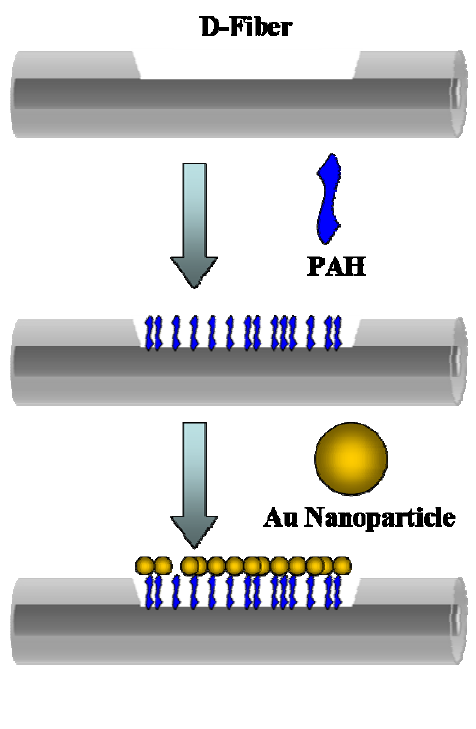
Figure 4. Schematic diagram of the modification of Au nanoparticles on the surface of the grooved optical fiber (D-type fiber was taken as an